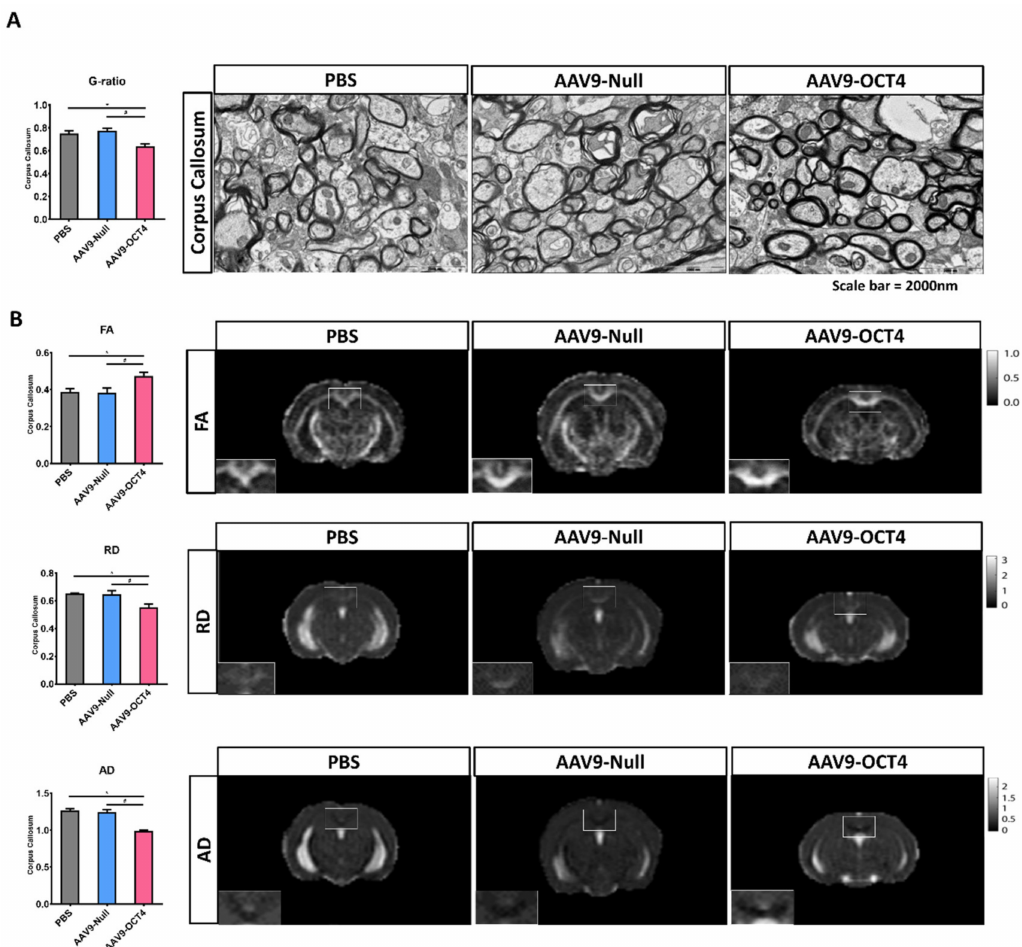
Figure 5. OCT4-induced OPCs ameliorate myelination deficits ( A ) TEM was used to visualize myelinated fibers in corpus callosum at 13 weeks of age, the value of g-ratio in the AAV9-OCT4 group was significantly lower than control groups (F = 11.442, * p = 0.001; # p < 0.001). ( B ) MRI results were analyzed for FA (F = 5.986, * p = 0.049; # p = 0.042), RD (F = 8.040, * p = 0.018; # p = 0.026) and AD (F = 34.309, * p = 0.015; # p = 0.019), myelination defects in the AAV9-OCT4 group was significantly ameliorated. *,# p < 0.05, Data in all panels represent mean ± SEM. * PBS vs. AAV9-OCT4, #AAV9-Null vs. AAV9-OCT4. PBS group (N = 3); AAV9-Null (N = 3); AAV9-OCT4 (N =